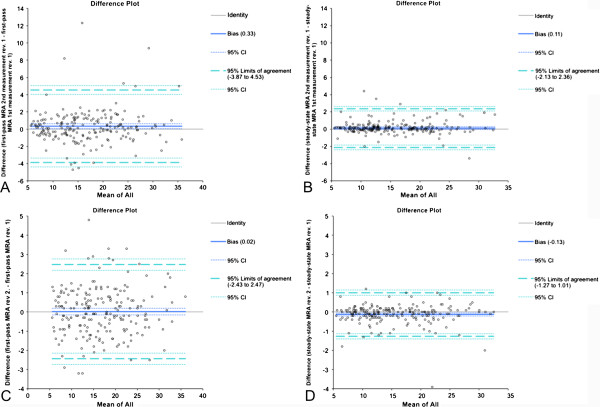
Intraobserver method agreement of FP-MRA- (A) and HR-MRA-measurements (B) of reviewer 1. Interobserver method agreement derived from FP-MRA (C) and HR-MRA (D) measurements of reviewers 1 and 2.